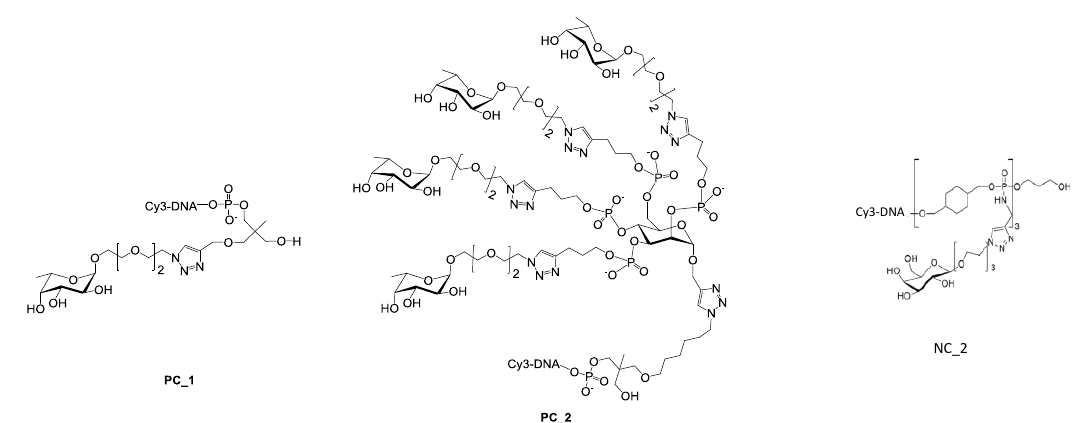
Figure 7. Structure of the two positive controls PC_1 and PC_2 [27] and the negative control NC_2. [42]. The data shows that the combination of xylose with an EG 2 linker ( G3 ) core is preferred, while with the EG 4 linker, the arabinose core leads to a higher binding-( G2 ). For hexose core ( G7 to G12